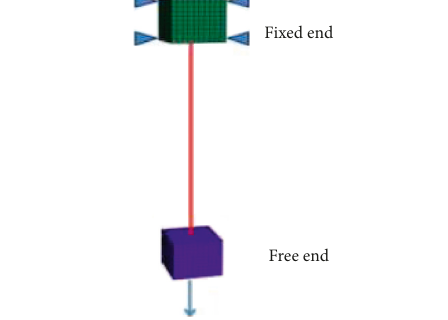
Figure 15: The NPR anchor cable model.